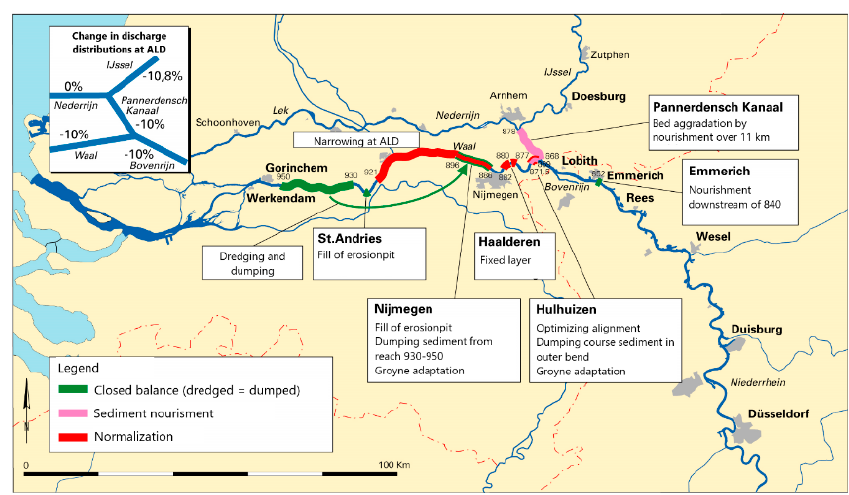
Figure 21. Sustainable Fairway Rhine Delta (SFR) solution direction B: compromise between water management and navigability (climate change alternative 10% less discharge, no change in discharge distribution at Pannerdensche Kop). Note the enormous impact on works to be implemented (copyright [7]).